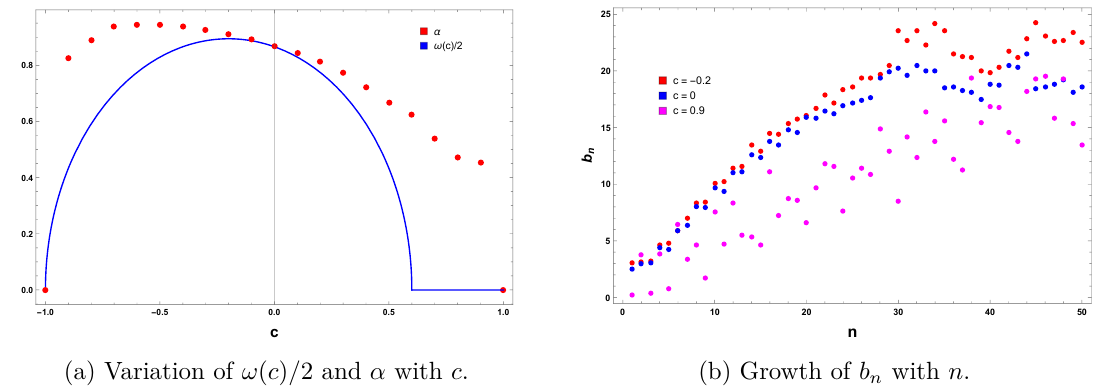
Figure 8. Saddle-point analysis of the classical FP model. (a) shows the variation of the exponent with parameter c . The largest growth is obtained for c = − 0 . 2 . The slope of the linear growth of the Lanczos coefficients ( α ) for different values of c is also plotted for s = s = 75 and for the 1 2 ≡ s operator choice ˆ O = ˆ x + ˆ x . As is evident, the bound is saturated only for c = 0 . Away from c = 0 , 1 2 we always have 2 α > ω ( c ) . (b) The Lanczos coefficients b for three different values of c n